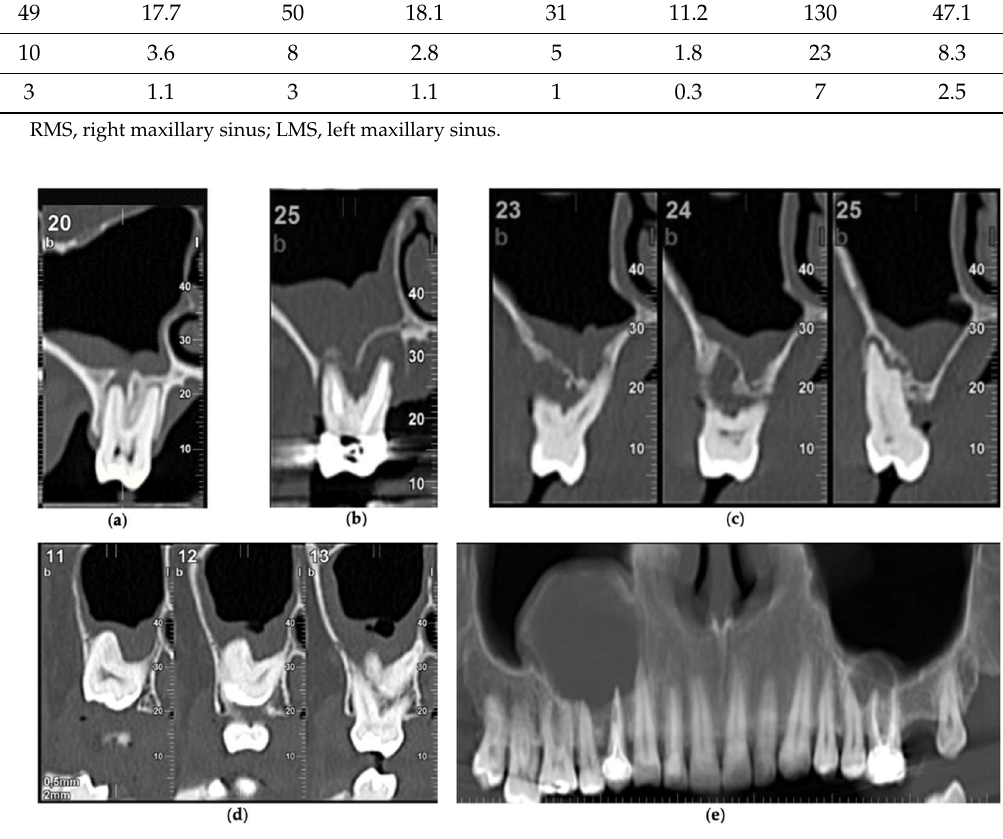
Figure 1. Dental factors triggering sinus thickening: ( a ) periapical pathology; ( b ) endodontic treat- ment; ( c ) periodontitis; ( d ) impacted third molar; ( e ) dental radicular cysts.